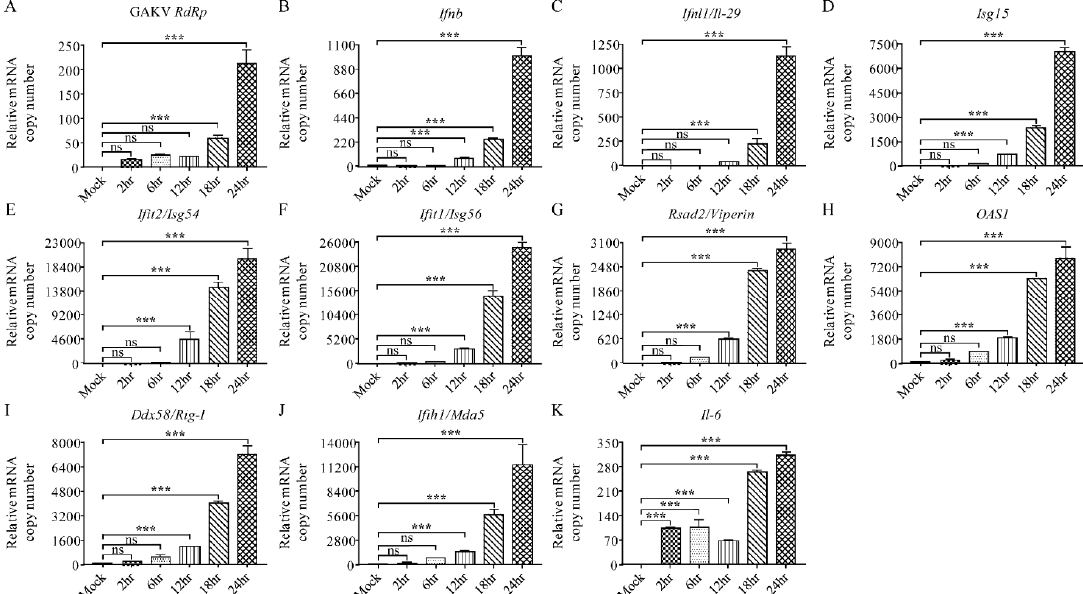
Figure 6. Enhanced expression of viral and innate antiviral genes in Gamak virus (GAKV)-infected A549 cells. A549 cells were infected with a GAKV at multiplicity of infection of 0.02. Total RNA was extracted and analyzed by quantitative reverse transcription-polymerase chain reaction (qRT-PCR) for the induction of ( A ) GAKV RdRp , ( B ) interferon- β ( Ifn- β ), ( C ) Ifnl1/Il-29 , ( D ) interferon-stimulated gene product-15 ( ISG-15 ), ( E ) Ifit2/Isg54 , ( F ) Ifit1/Isg56 , ( G ) radical S-adenosyl me- thionine domain containing 2 ( Rsad2/Viperin ), ( H ) 2 ′ , 5 ′ -oligoadenylate synthetase 1 ( OAS1 ), ( I ) Ddx58/Rig-I , ( J ) Ifih1/Mda5 , and ( K ) interleukin-6 ( Il-6 ) at 2, 6, 12, 18, and 24 h postinfection. Error bars show the standard deviation of triplicate measurements in a representative experiment. *** p < 0.001, one-way analysis of variance (ANOVA) test; ns: non-signifi- cant.